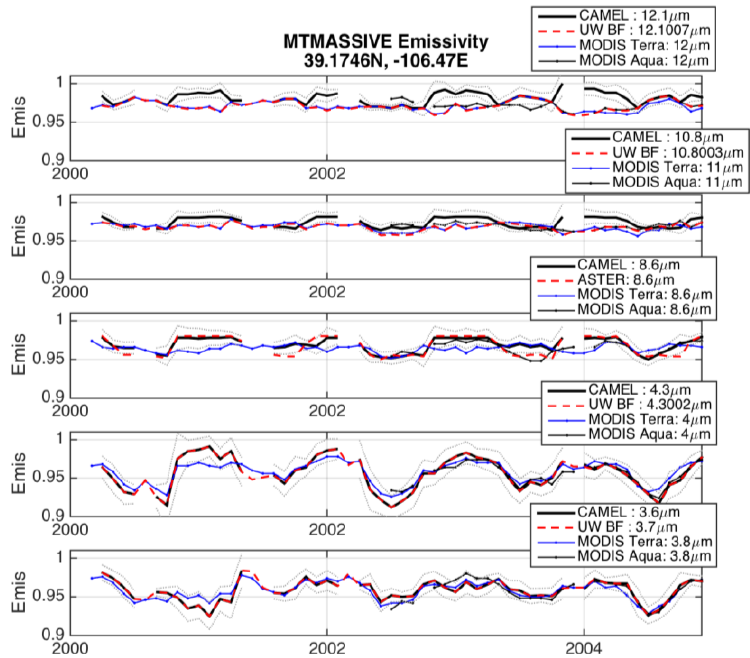
Figure 11. The CAMEL dataset is currently available for the years 2003–2015, and makes use of the Aqua MODIS data as input to the 13 hinge-point product. The dataset is now extended to 2000, and uses the Terra MODIS data for the months of 2000 through December 2002. Time series of the CAMEL, ASTER GEDv4, UW BF (UW BF), and MODIS emissivity are shown, and demonstrate consistency between the Aqua and Terra products over the Rocky Mountain case site. Table 3. Definition of the CAMEL emissivity quality flag.